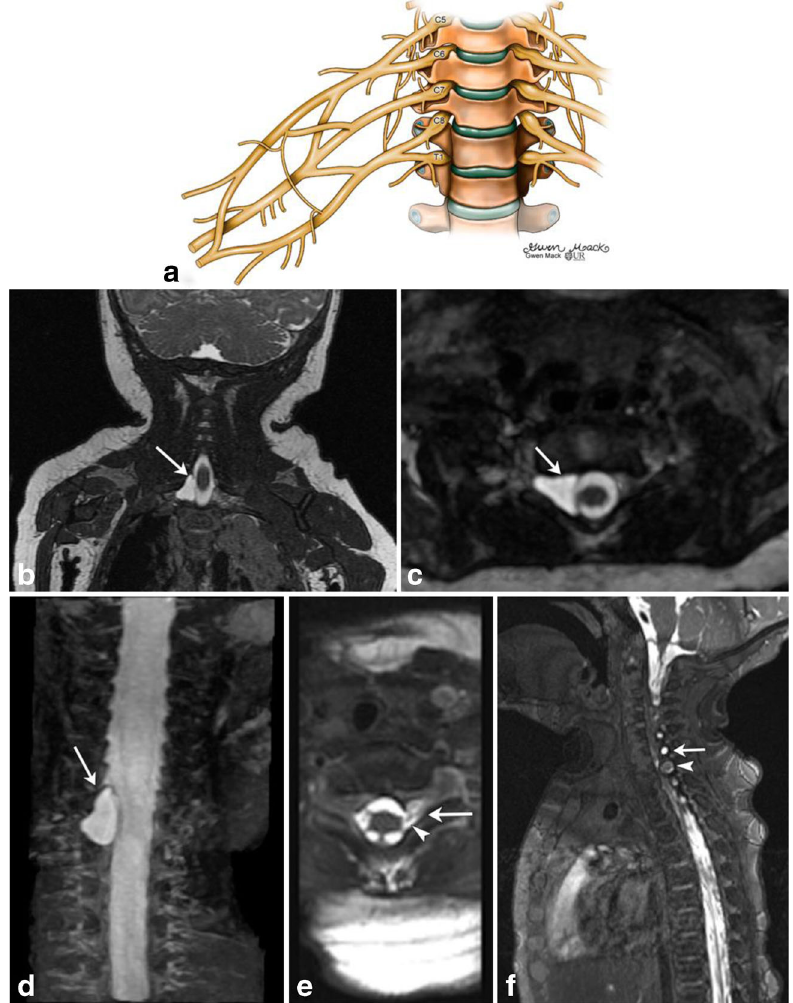
pseudomeningocele formation at the level of C8 (arrow) with disruption of the ventral nerve root (arrowhead). Sagittal MR SSFP image (f) shows disorganizedsoft tissue within theleft C8foramenwith focal enlargement of the nerve at the exit of the neural foramen, consistent with neuroma formation (arrowhead). A smaller pseudomeningocele is also noted at C7